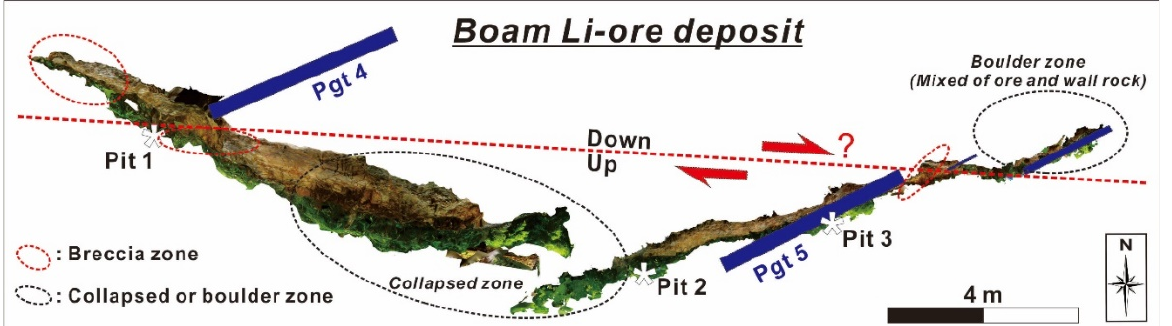
Figure 7. Map of the main rare ‐ element pegmatite (REP) bodies of the Boam deposit. REP bodies Pgt 4 and Pgt 5 are highlighted with thick blue lines, and the WNW–ESE ‐ striking fault is shown by a red dotted line. Breccia zones and collapsed (or boulder) zones are highlighted by red and black dotted circles, respectively.